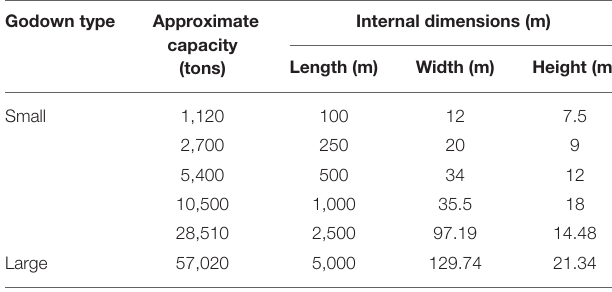
TABLE 3 | Bag storage godown/ warehouse capacities and their dimensions.